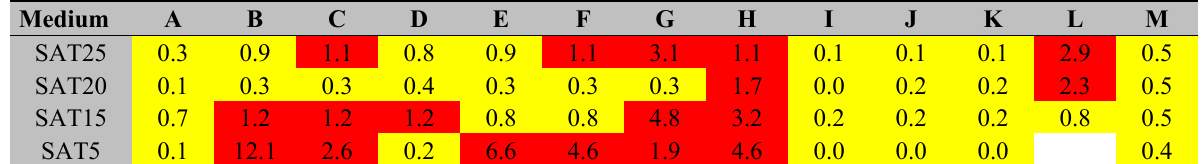
Table 7. The | E | numbers of the participants for temperature measurement a n